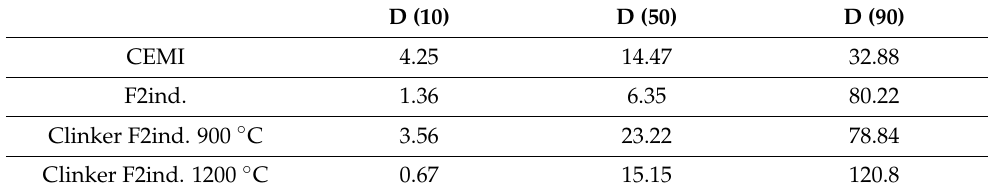
Table 5. Median particle sizes: D (10), D (50) and D (90) of CEM I, F2ind, Clinker F2ind. 900 ◦